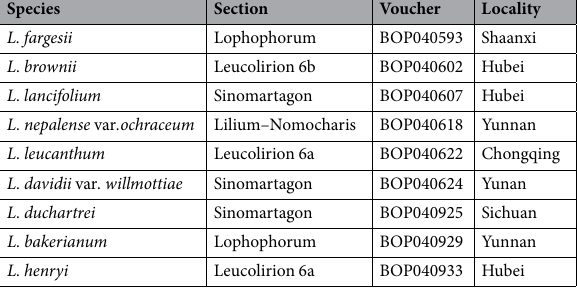
Table 5. Sampled species and their voucher specimens used in this